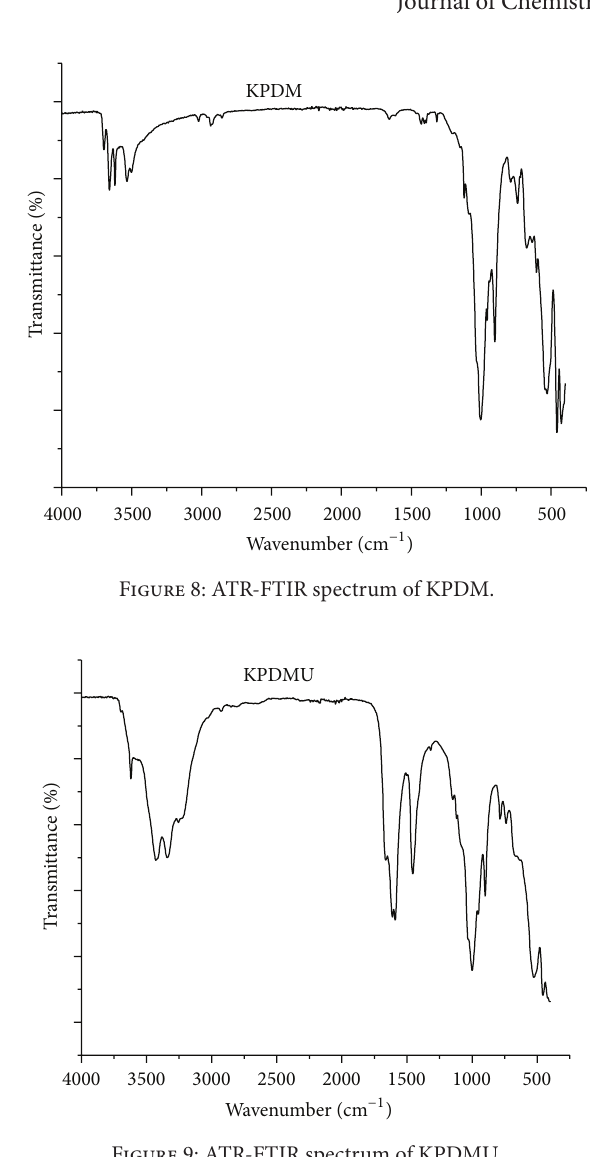
Figure 9: ATR-FTIR spectrum of